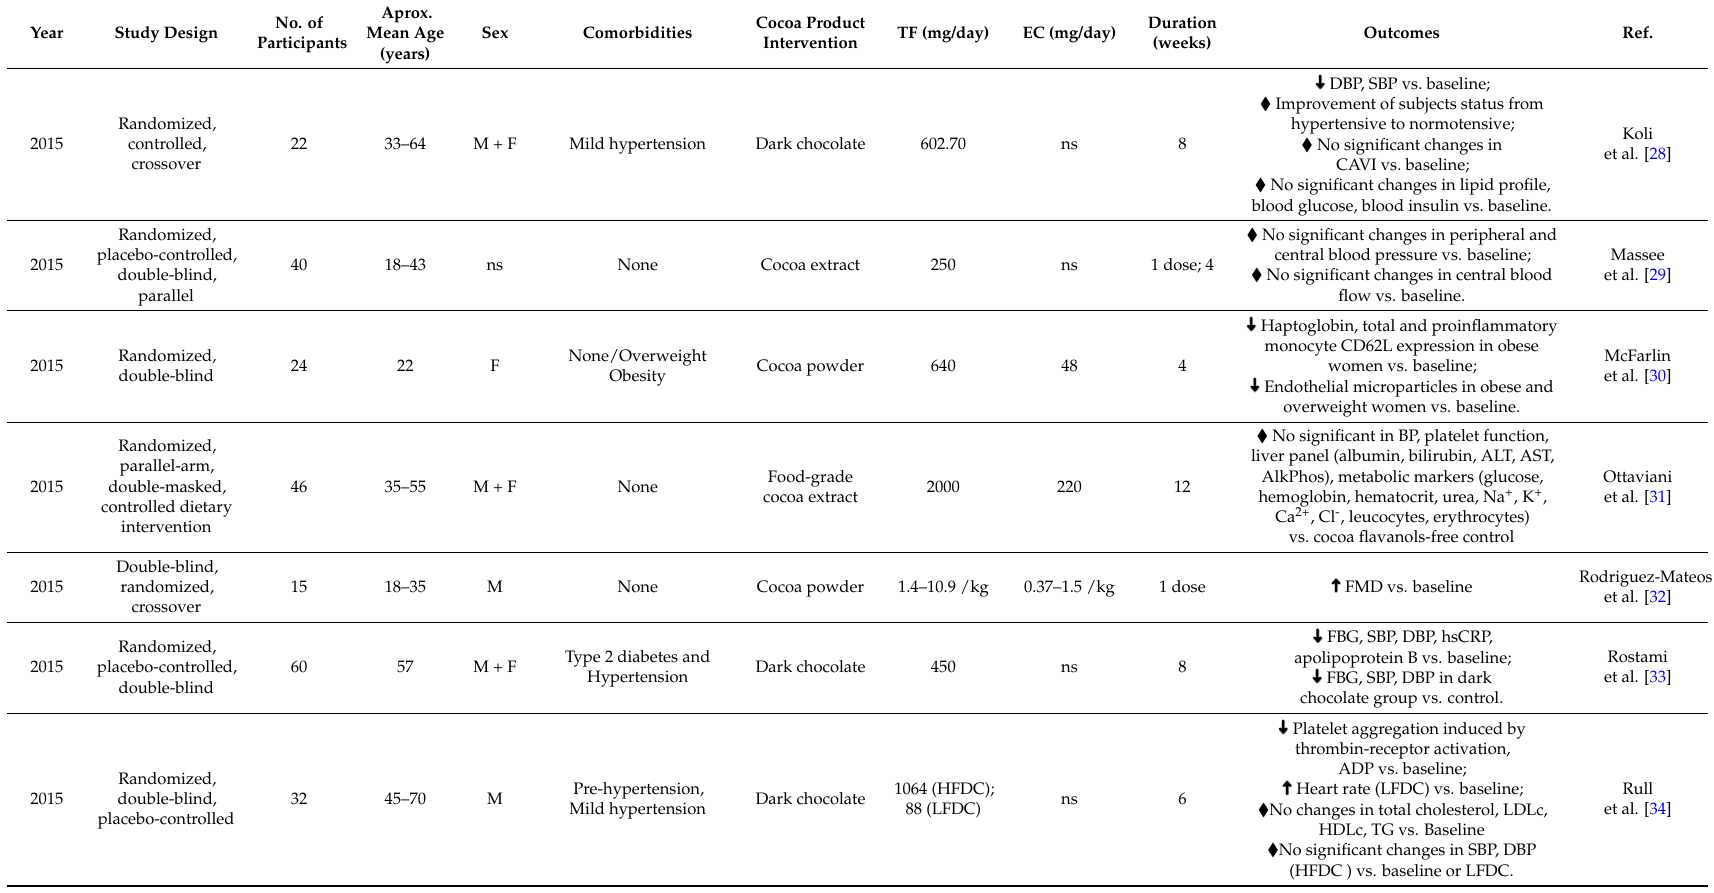
Table 1. Cont. Table 1. Outcomes of recent (2014–2016) clinical trials of cocoa products.